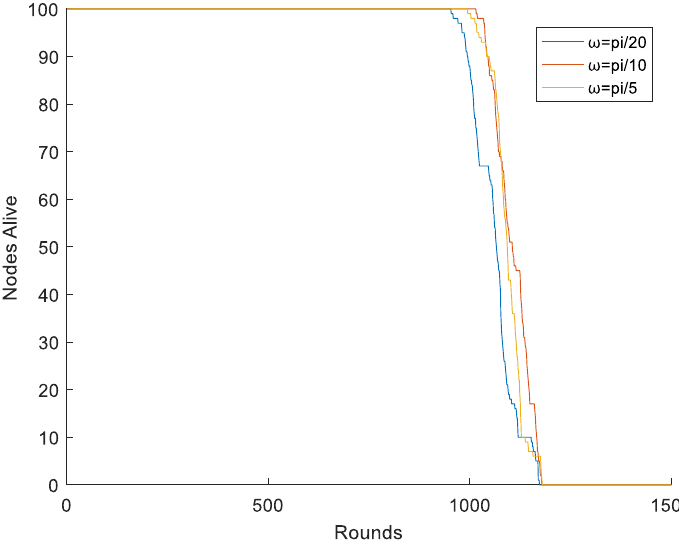
Figure 14. Different speed of the mobile sink.